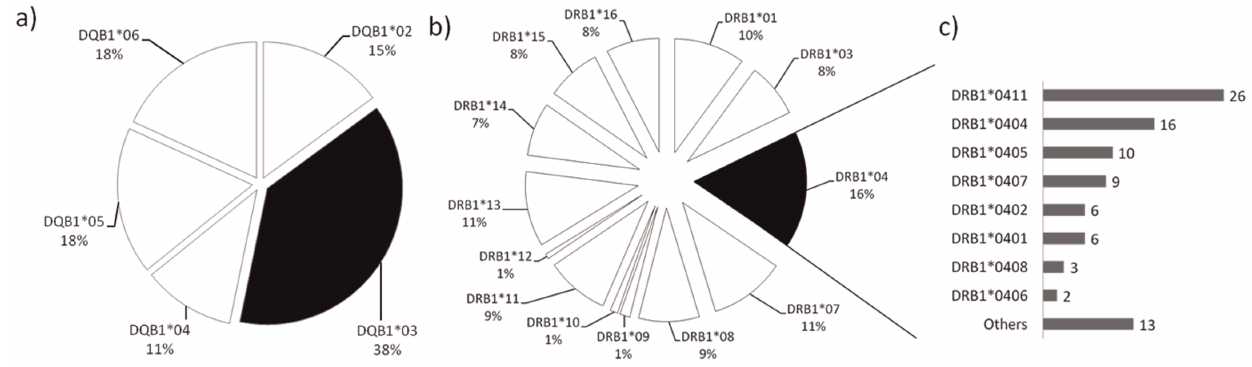
Figure 1. HLA allele frequencies in individuals naturally exposed to malaria from the Rondonia state. HLA-DQB1* (a) and HLA-DRB1* (b) allele frequencies (%) in 276 individuals naturally exposed to malaria from the Rondonia state enrolled in our study. HLA-DQB1*03 and HLA-DRB1*04 present significantly higher frequencies when compared with all other groups observed (P , 0,05 and P , 0,01 respectively). Others: DRB1*09, DRB1*10, DRB1*12. The high resolution allele frequency distribution among the 91 HLA-DRB1*04 carriers from our studied area (c) also show a large variety of alleles, with a marked predominance of HLA-DRB1*04:11 (28%) over the others (P , 0.05).